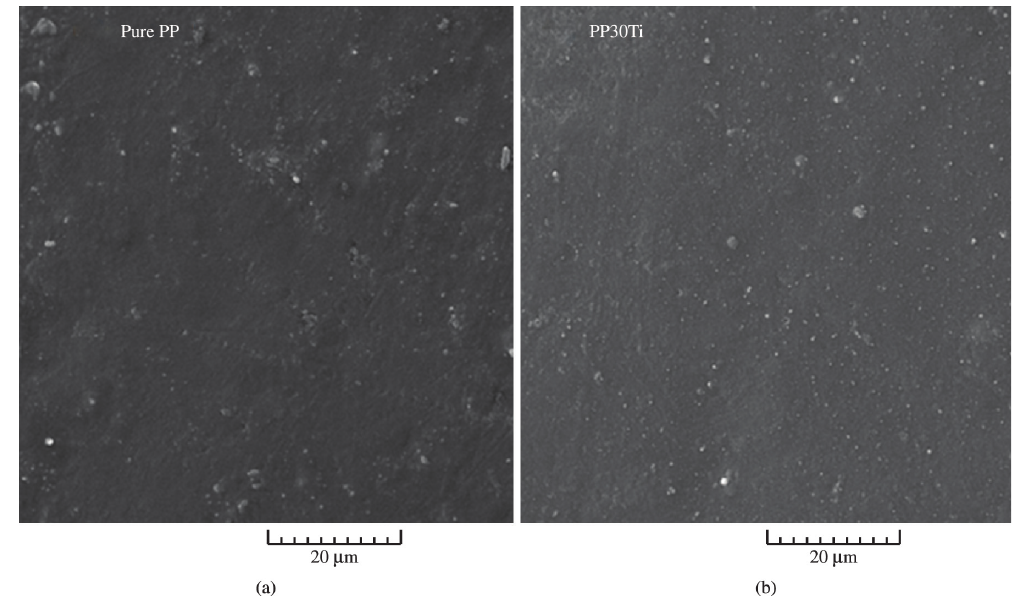
Figure 4. SEM images of (a) pure PP and (b) PP30Ti samples before radiation.